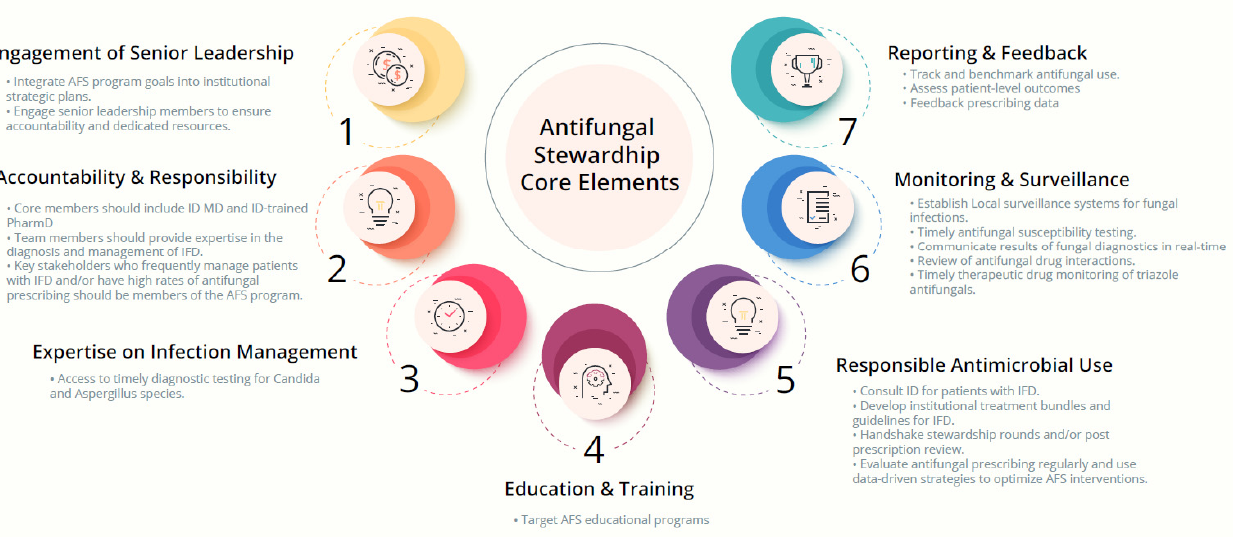
Figure 1. Mycoses Study Group Education and Research Consortium Antifungal Stewardship Core Elements [12].